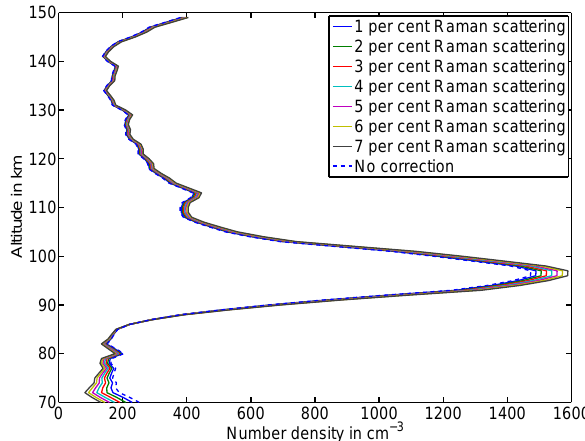
Fig. 30. Plot of Mg average profile of all single day results of the 2-D retrieval in the equatorial region (15 ◦ S to 15 ◦ N) for different percentages of Raman scattering in the Ring effect correction. The different corrections mainly affect the peak density and the lower peak edge. The peak altitude is nearly unaffected. Differences for variations of 1% in the Raman scattering percentage vary the lower peak edge altitude by ≈ 1km for altitudes above 80km. For alti- tudes below 80km, the differences drastically rise.